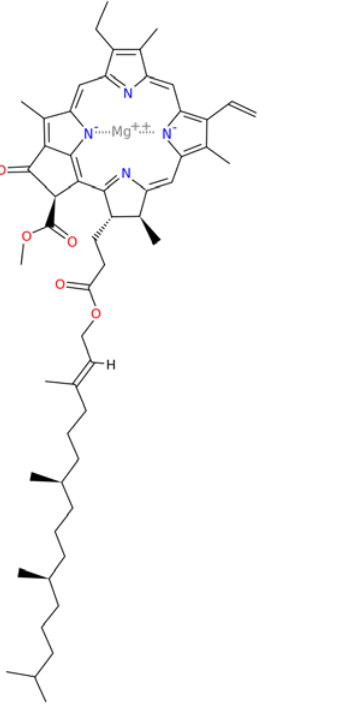
Figure 2. Structure of chlorophyll-a (Chl-a).